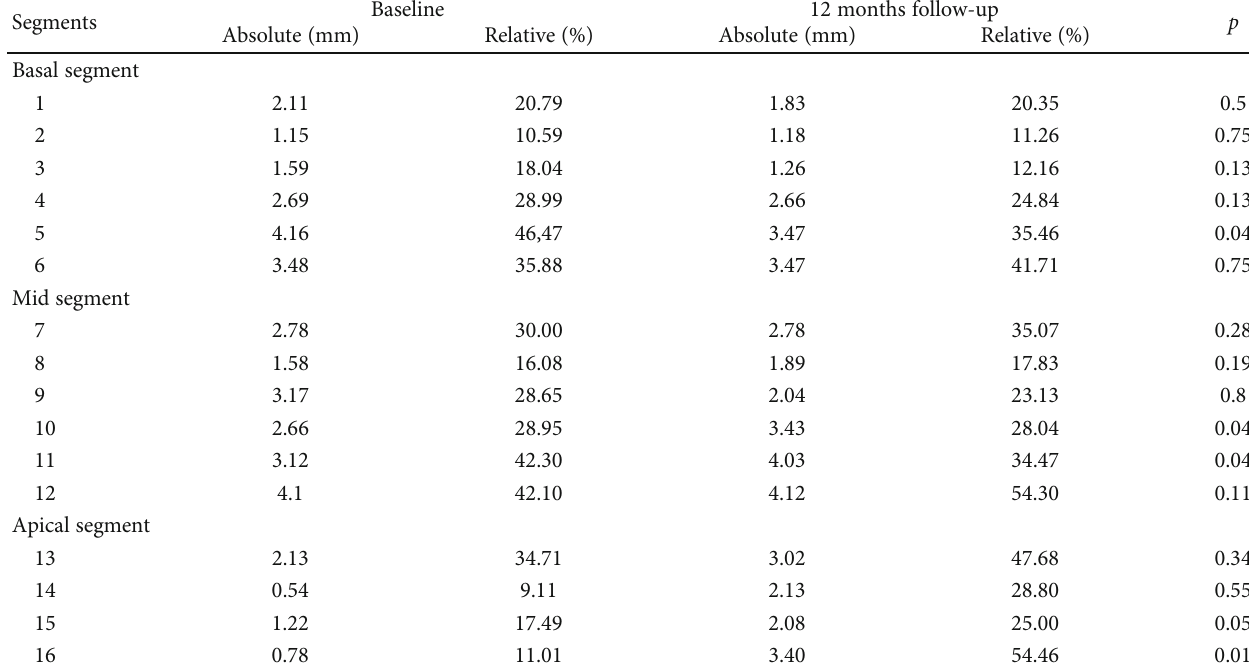
Table 3: Regional myocardial thickening assessed by cardiac magnetic